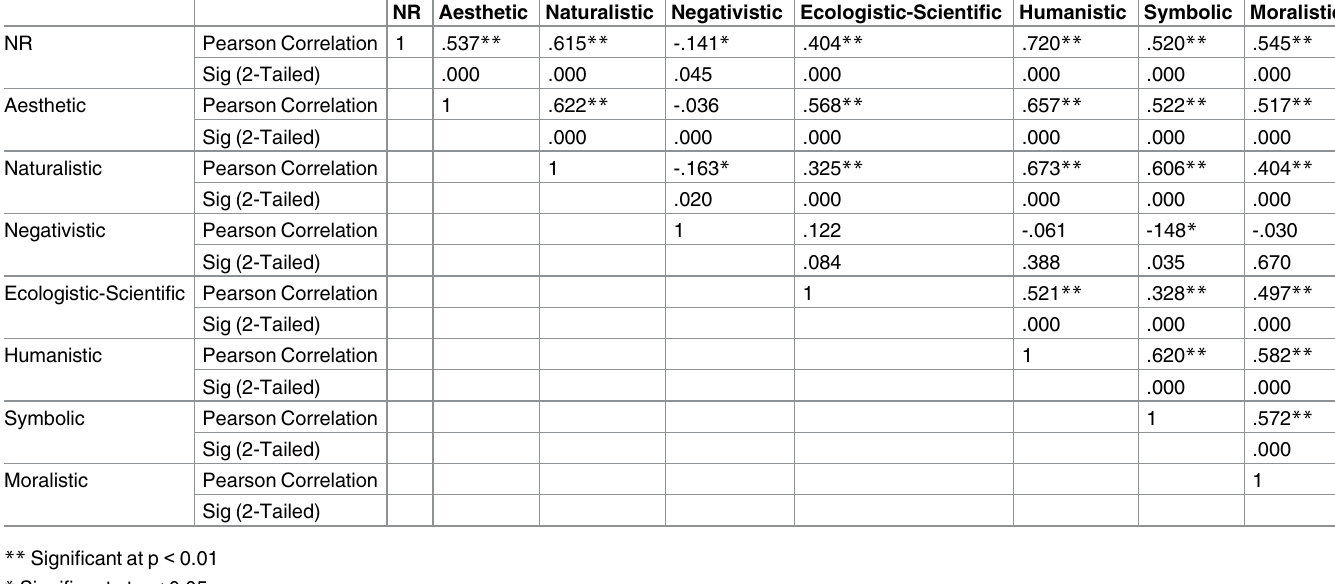
Table 5. Inter-Correlations between engaging with the nine values of biophilia (N =